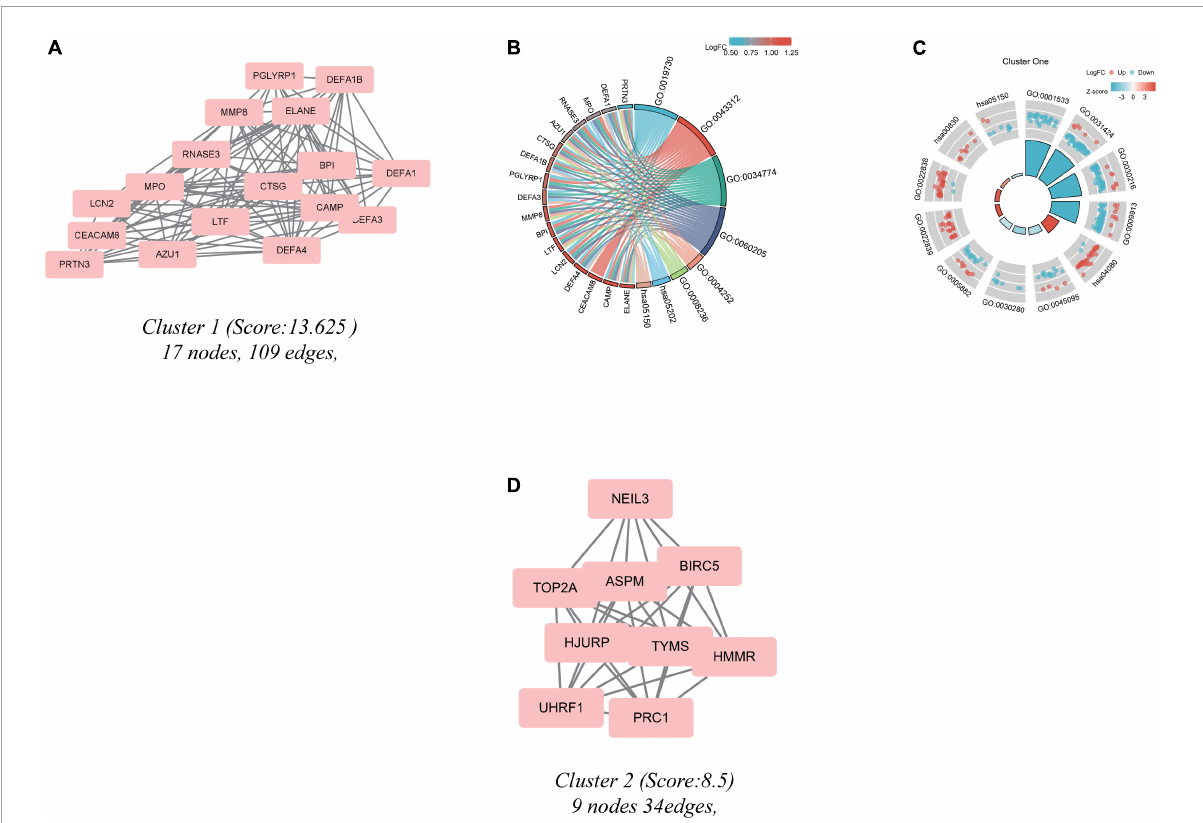
FIGURE4 Cluster modules extracted by MCODE and enrichment analysis of the modular genes. (A,D) Significant gene clustering modules. (B,C) GO and KEGG enrichment analysis of the first modular genes. Two cluster modules extracted by MCODE. Cluster 1 (A) had the higher cluster score (MCODE score = 13.625), followed by cluster 2 (D) (MCODE score = 8.5). Adjusted P value < 0.05 was considered